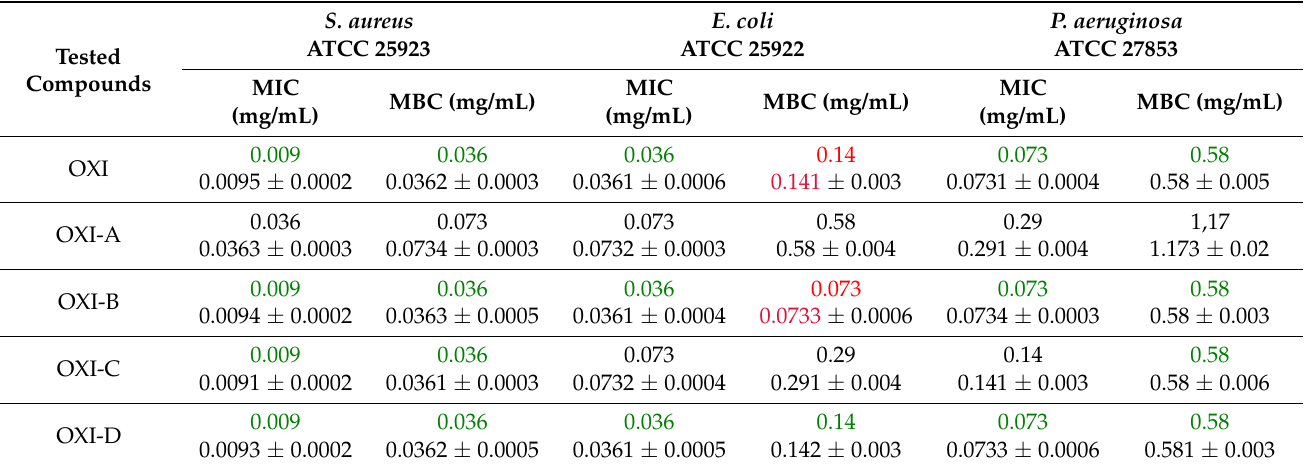
Table 4. Minimum inhibitory concentration and minimum bactericidal concentrations of the tested